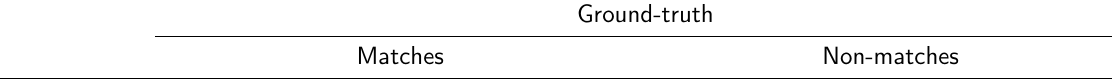
Table 2: Confusion matrix for link classification according to ground-truth and predicted clusters. Ground-truth Matches Non-matches Prediction Positive Link True Positives (TP) - Record pairs that ap- False Positives (FP) - Record pairs that pear in the same cluster both in the ground- appear in the same cluster in the prediction truth and in the prediction. Known as true but in different clusters in the ground-truth. matches . Known as false matches . Negative Link False Negatives (FN) - Record pairs that True Negatives (TN) - Record pairs that appear in the same cluster in the ground- appear in different clusters both in the truth but in different clusters in the predic- ground-truth and prediction. Known as true tion. Known as false non-matches or missed non-matches matches .